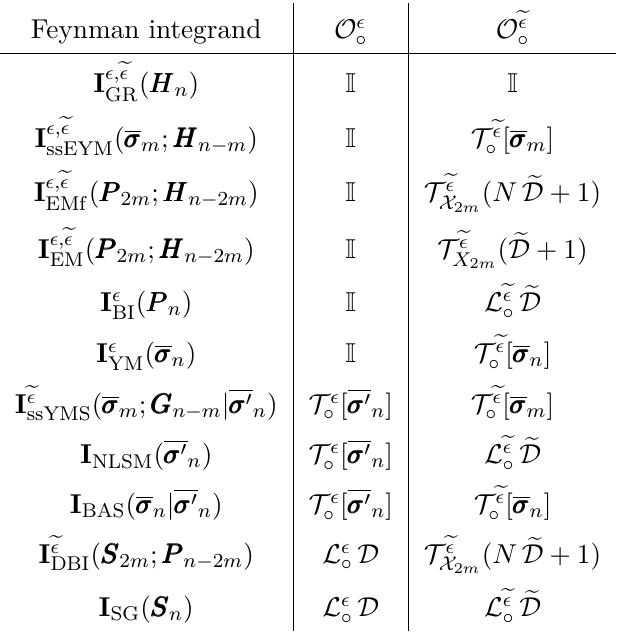
Table 4 . Unifying relations at 1 -loop